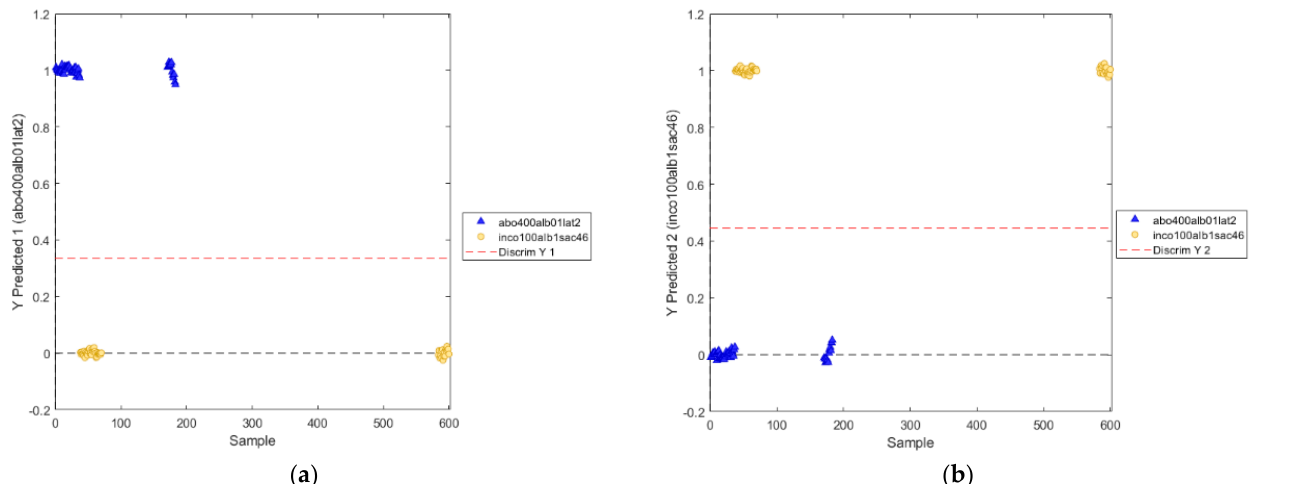
Figure 12. Positions of the discrimination boundary as determined by PLS − DA model (utilized wavelength range: 800 − 2400 nm) for the two classes: abobotulinum A toxin ( a ) and incobotulinum A toxin ( b ).